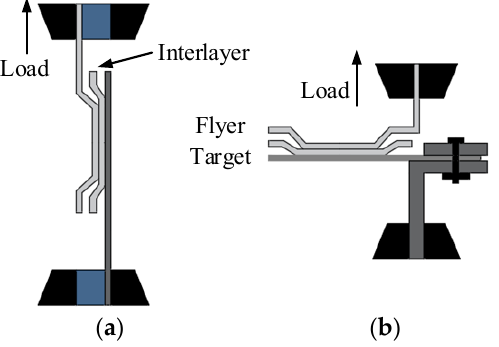
Figure 2. Mechanical testing schematic. ( a ) Peel test; ( b ) Lap-shear test.